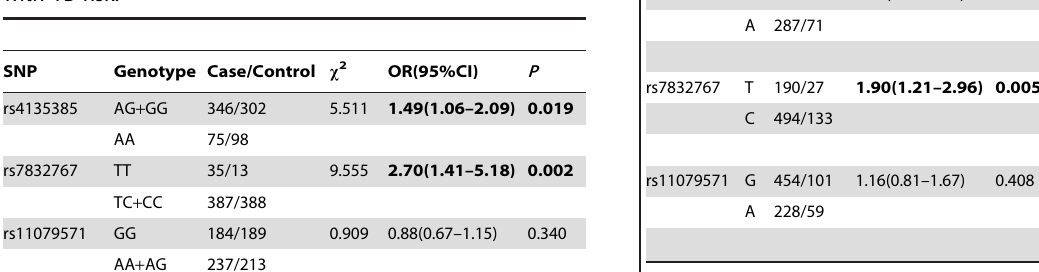
Table 3. Association of Wnt pathway gene polymorphisms with TB risk.